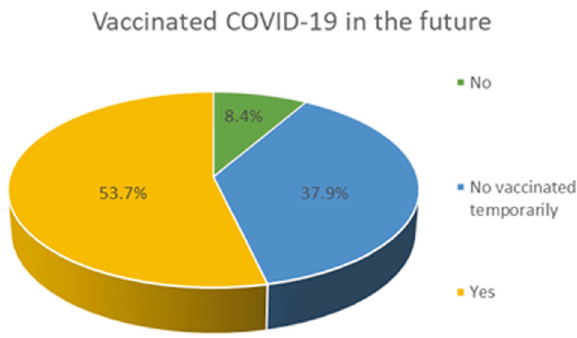
Fig. 1 Behavior toward COVID-19 vaccines ( N =